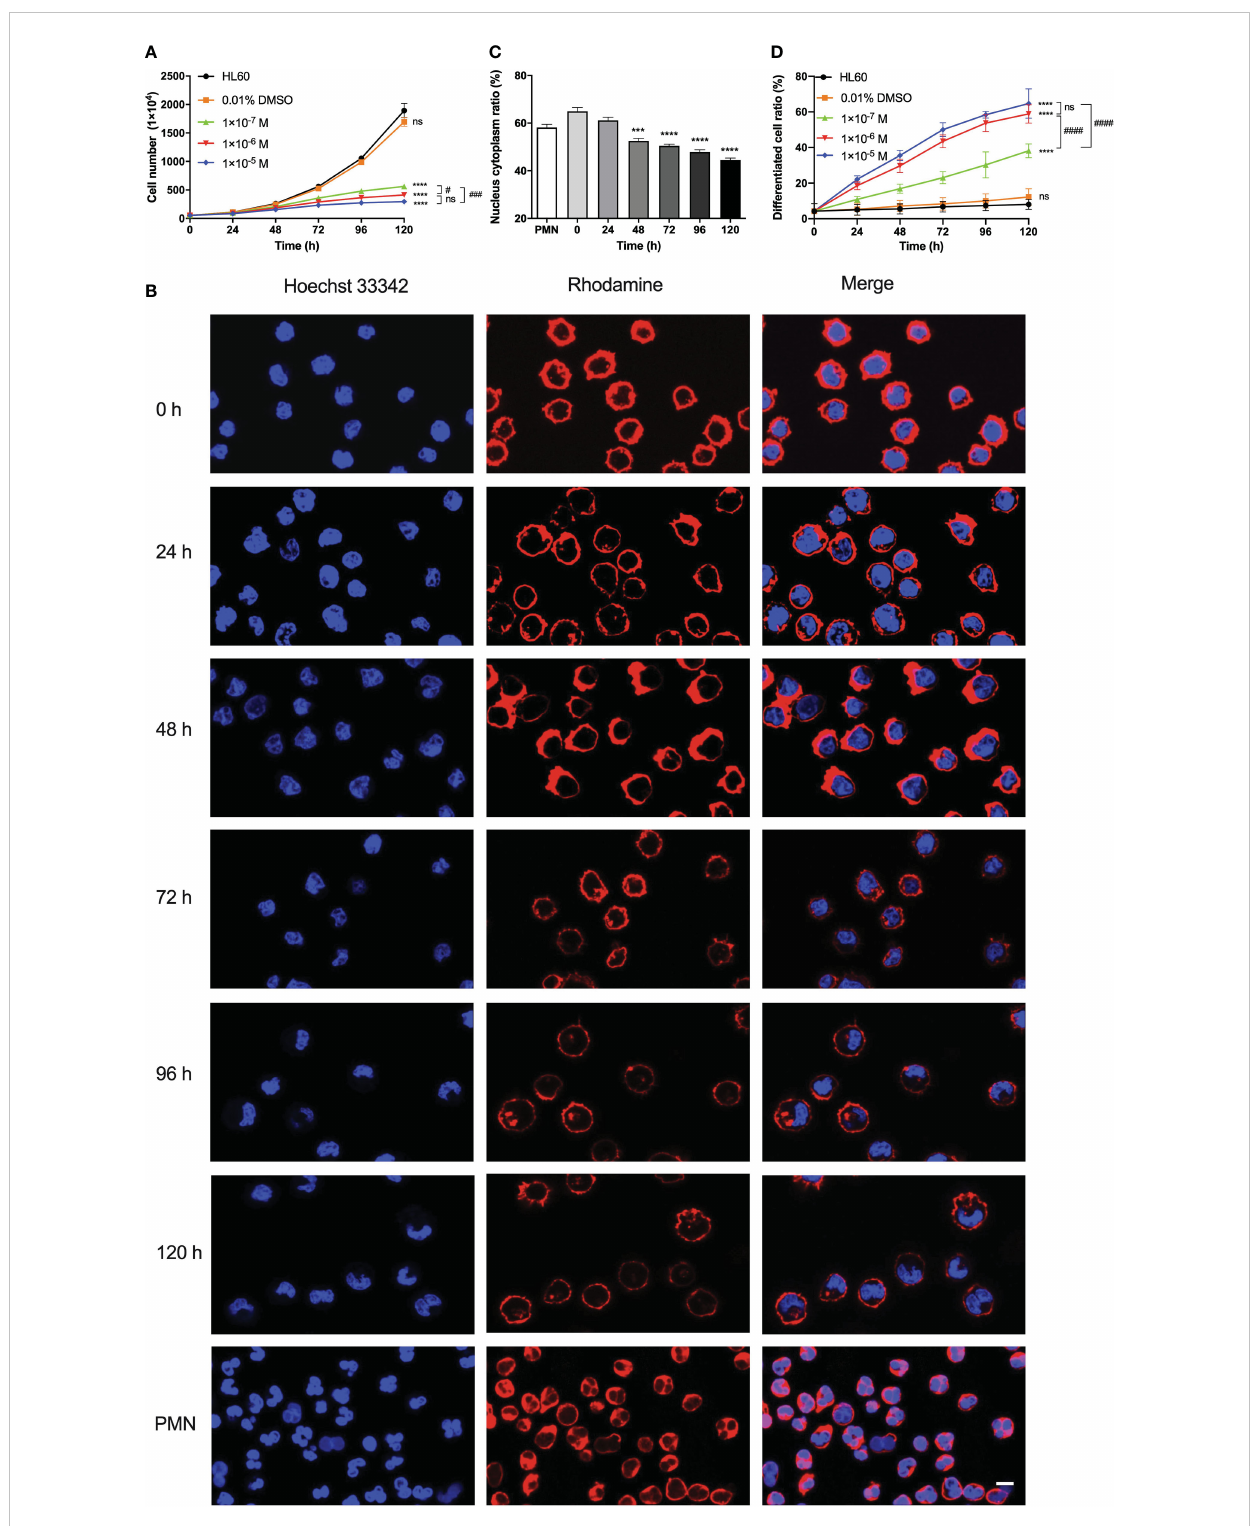
FIGURE 1 Effects of all-trans retinoic acid (ATRA) concentrations and stimulus time on the proliferation, morphology, radius, and differentiation of HL60 cells. (A) Growth curves of HL60 cells. We treated the cells with 0.01% DMSO, 1 × 10 -5 M, 1 × 10 -6 M, and 1 × 10 -7 M ATRA, or nothing, respectively, for different stimulus times from 0 to 120 h. (B) Images of F-actin (red) and nuclei (blue) of polymorphonuclear neutrophil (PMN) and HL60 cells treated with 1 × 10 -6 M ATRA for different stimulus times. Length scale bar = 5 m m. (C) Plots of nuclear-to-cytoplasmic (N/C) volume ratio against culture time for the 1 × 10 -6 M ATRA-treated HL60 cells. (D) Variation of differentiated cell ratio (the ratio of differentiated cells to total cells) for HL60 cells treated with nothing (control), 0.01% DMSO only, and 1 × 10 -5 , 1 × 10 -6 , or 1 × 10 -7 M ATRA. The results from three independent experiments are shown as mean ± SD. Statistical signi fi cance was analyzed by two-way ANOVA followed by Tukey ’ s multiple-comparisons tests (A, D) or Student ’ s t -tests (C) , and the signi fi cant level of difference was shown by the P -value. ***, P < 0.001 in comparison with just PMN (C) , ****, P < 0.0001 in comparison with the HL60 group (A, D) or PMN (C) . #, P < 0.05; ###, P < 0.001; ####, P < 0.0001, and ns means no signi fi cant